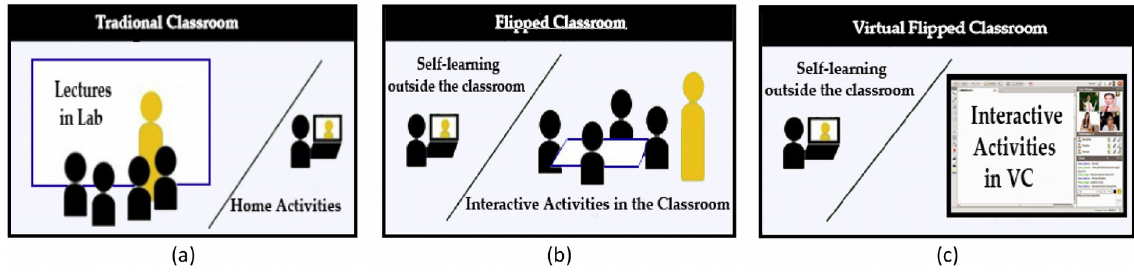
Figure 1. Traditional classroom, flipped classroom, and virtual flipped classroom